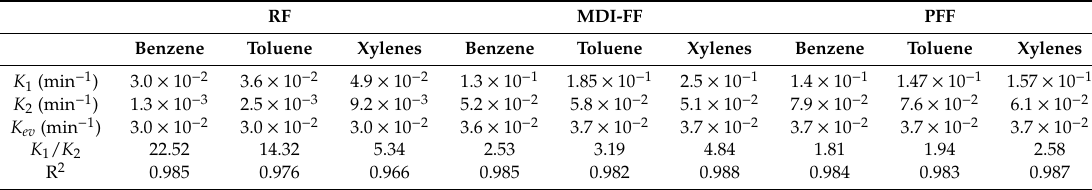
Table 4. Fitting results of the kinetic model (Equation